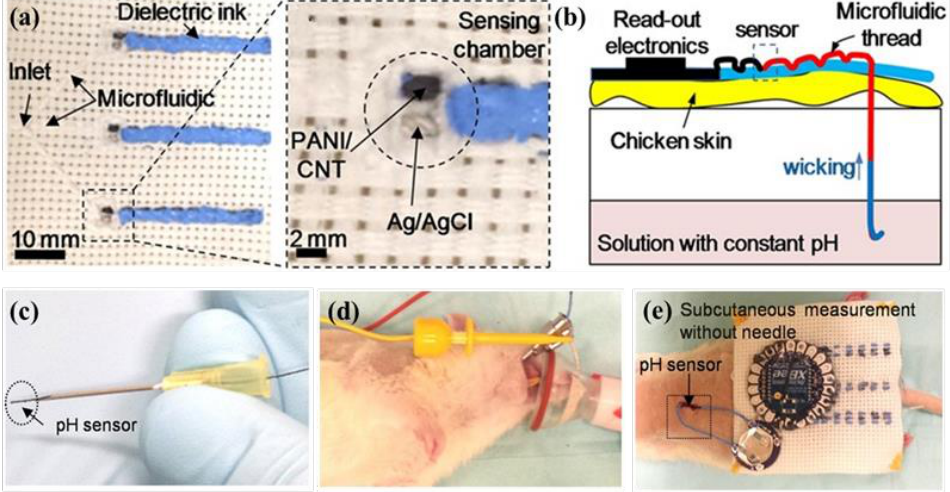
Figure 4. ( a ) Optical images of conductive thread-based pH sensor array; ( b ) mechanism of microfluidic pH sensor in skin wound pH detection; ( c ) the thread-based pH sensor passed through a normal needle; images of the thread-based pH sensor used for ( d ) stomach and ( e ) subcutaneous pH sensing (Reprinted from [58]).